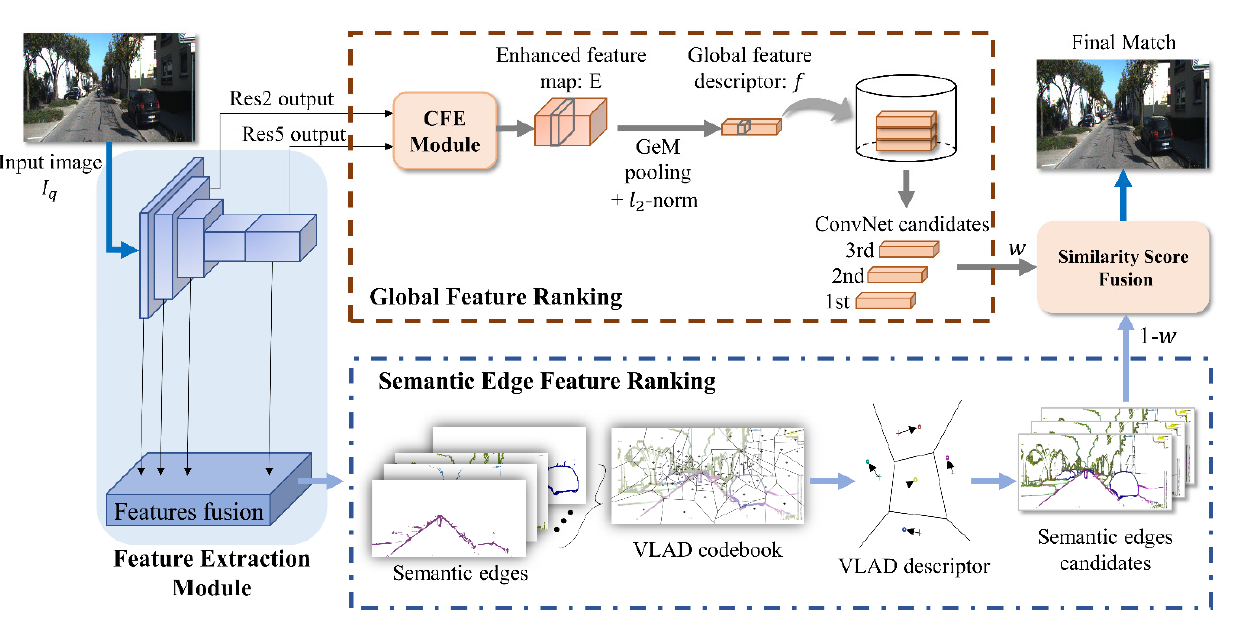
Figure 1. An overview of the proposed module. As the incoming image stream enters the pipeline, the ConvNet features and the semantic edge features of the image are extracted by the feature extraction module. The first ones enter the global feature ranking branch to retrieve the most similar ConvNet candidates. The semantic edges are sent to the semantic edge feature ranking branch to select the most similar images in human vision. Finally, the matched image pair is generated by similarity score fusion computation.